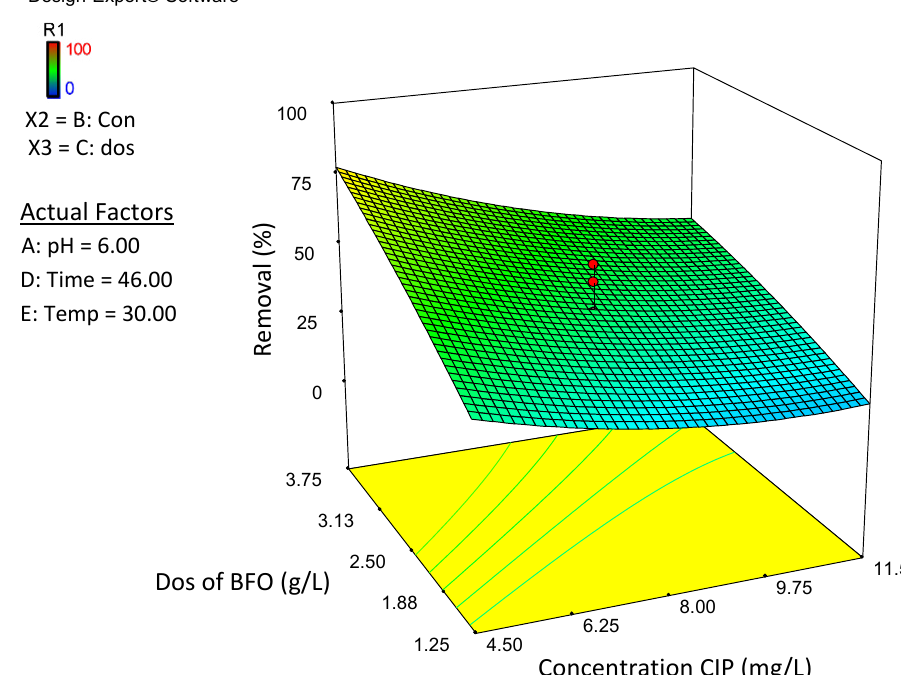
Fig.4: The 3D response surface plot of the mutual effects of CIP initial concentration and BFO dosage on removal efficiency under RSM method